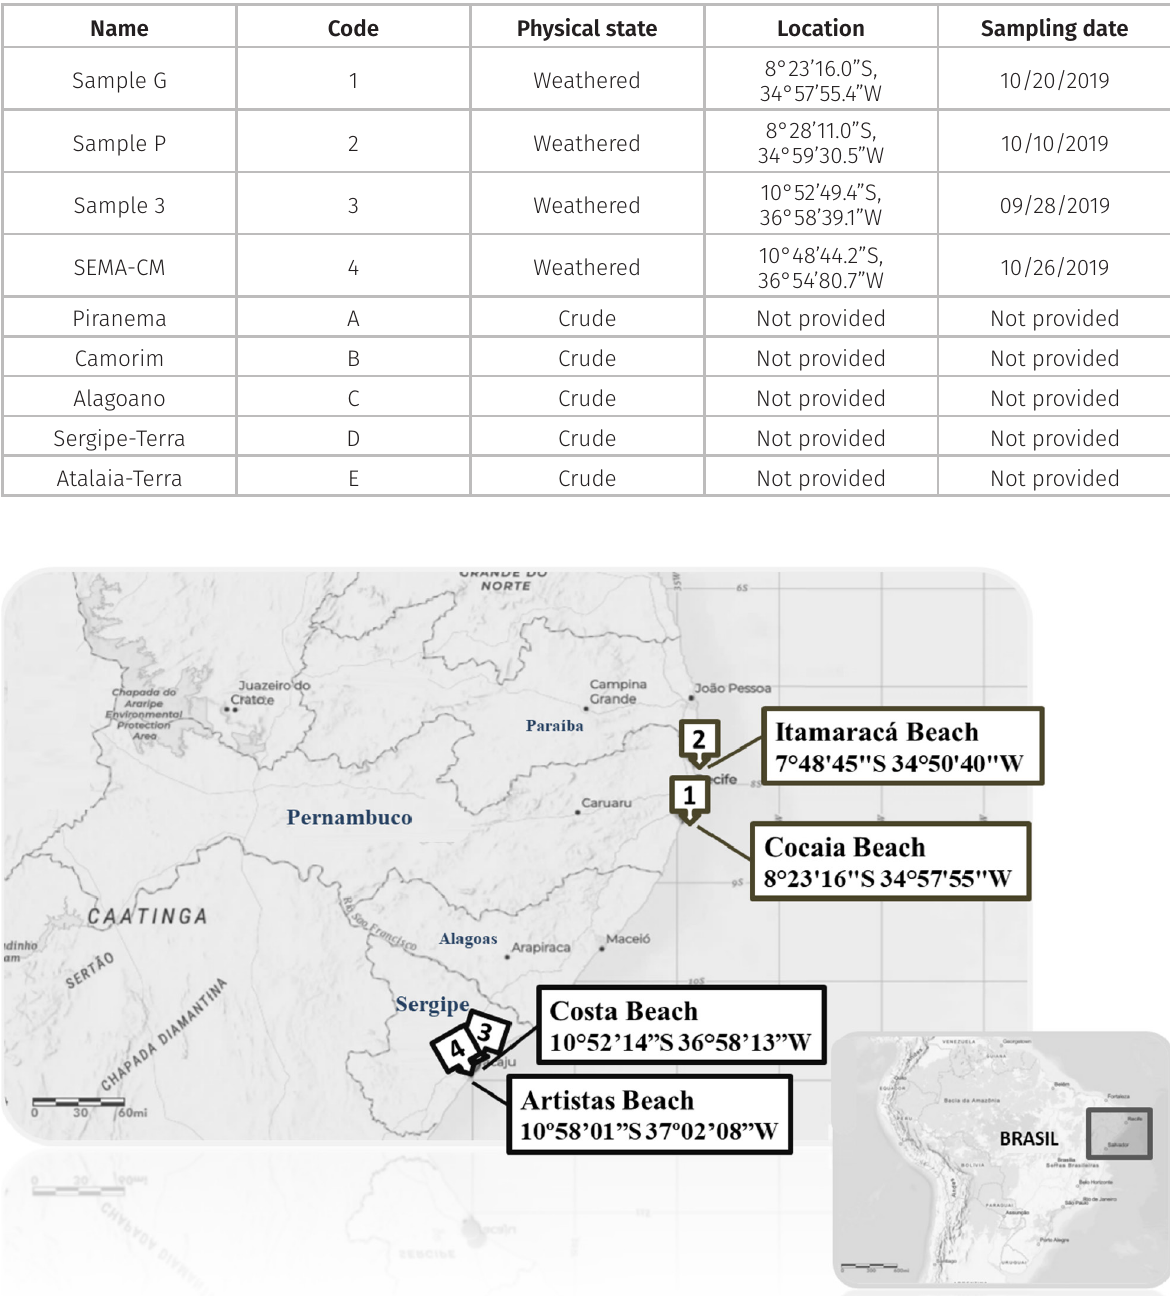
Table I. Sergipe-Alagoas basin crude oils and samples of weathered crude oil collected from sites along the Sergipe and Pernambuco coasts between September 28, 2019, and October 26, 2019.